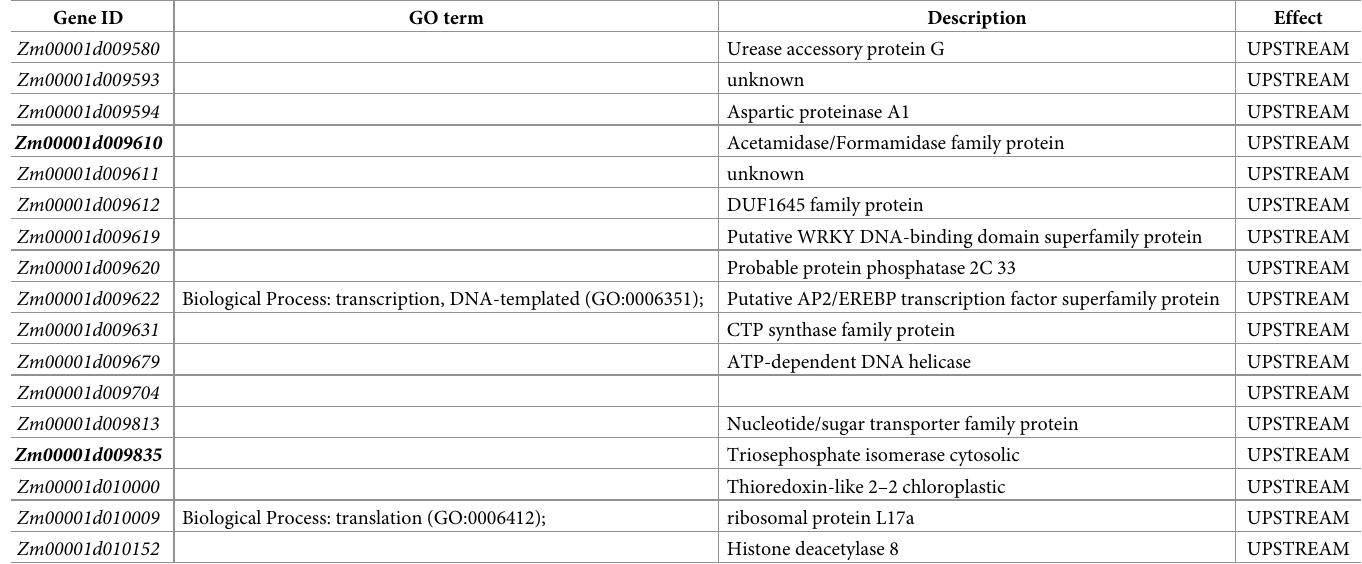
Table 6. Selected candidate genes of leaf angle in qLA08-01 with mutations in the promoter region. Gene ID